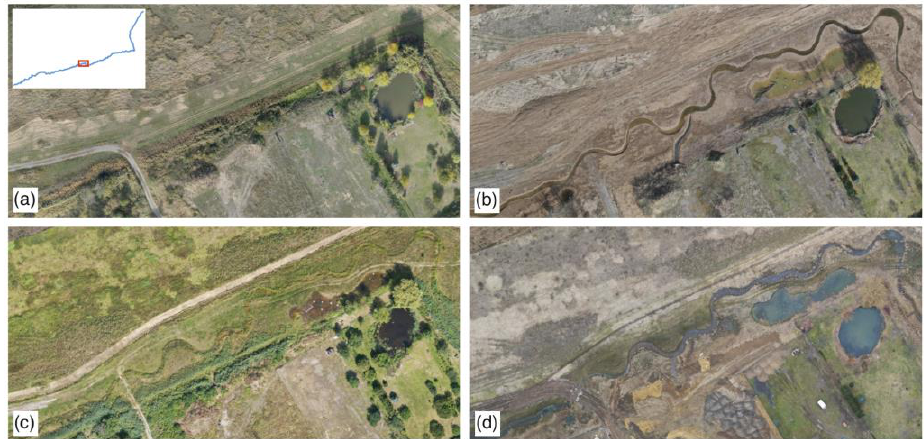
Figure 10. Changes in riparian vegetation coherence in the LIP brook. ( a ) Pre-restoration status (October 2018), ( b ) Completed restoration (March 2019), ( c ) One year after restoration (July 2020), ( d ) Disturbance of the completed restoration by construction works (March 2021). Imagery: J. Langhammer, 2018 – 2021.